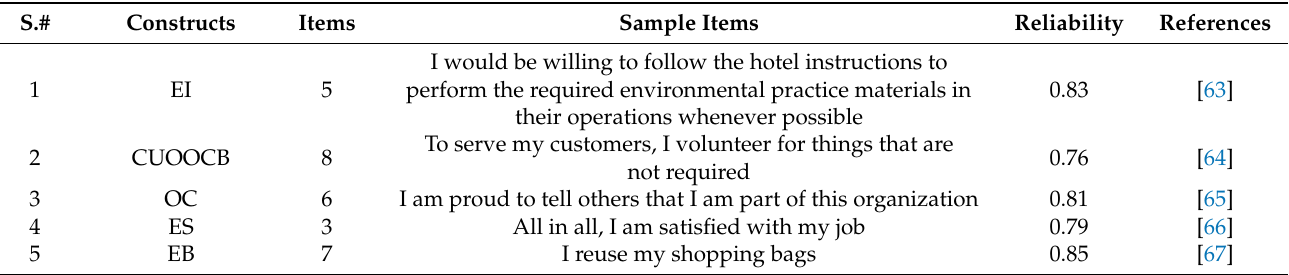
Table 1. Study variables, reliability, sample items, and